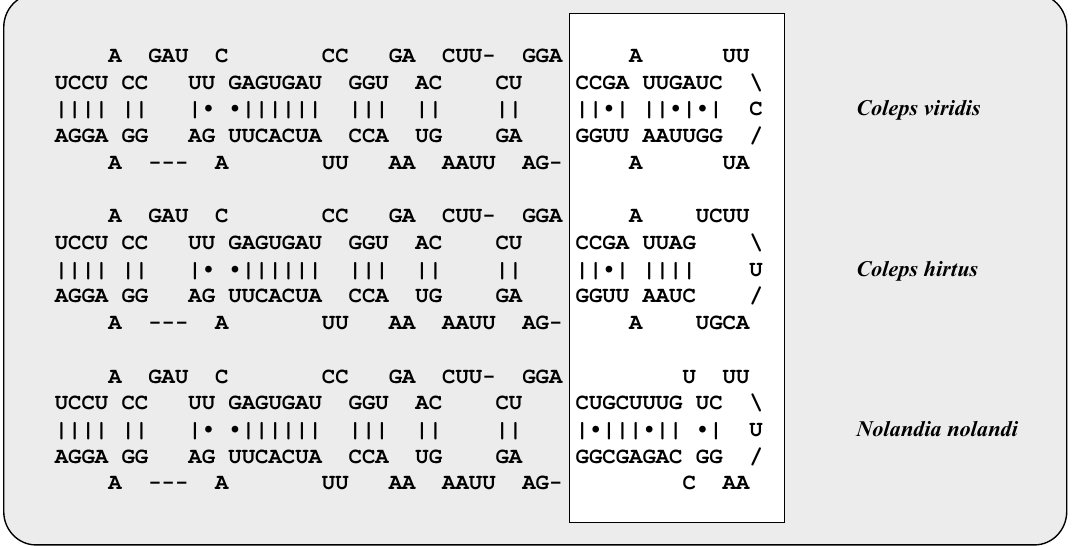
Figure 5. Comparisons of the V9 secondary structures among the species of Coleps and Nolandia . The structures were calculated with mfold 42 .